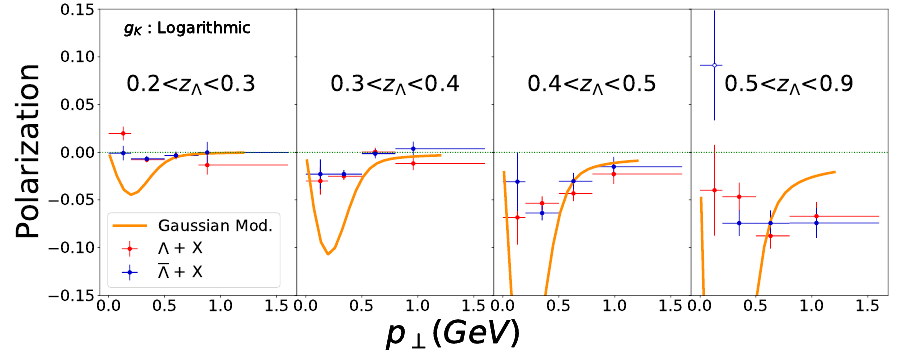
¯Λ production compared ) and the 2-h K